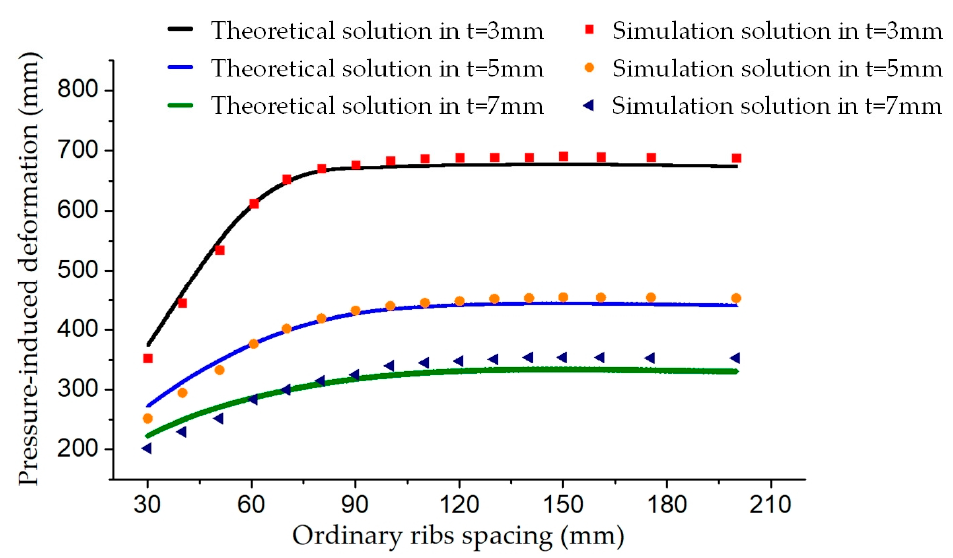
Figure 11. The finite element simulation analysis of the optimized pressure hull.